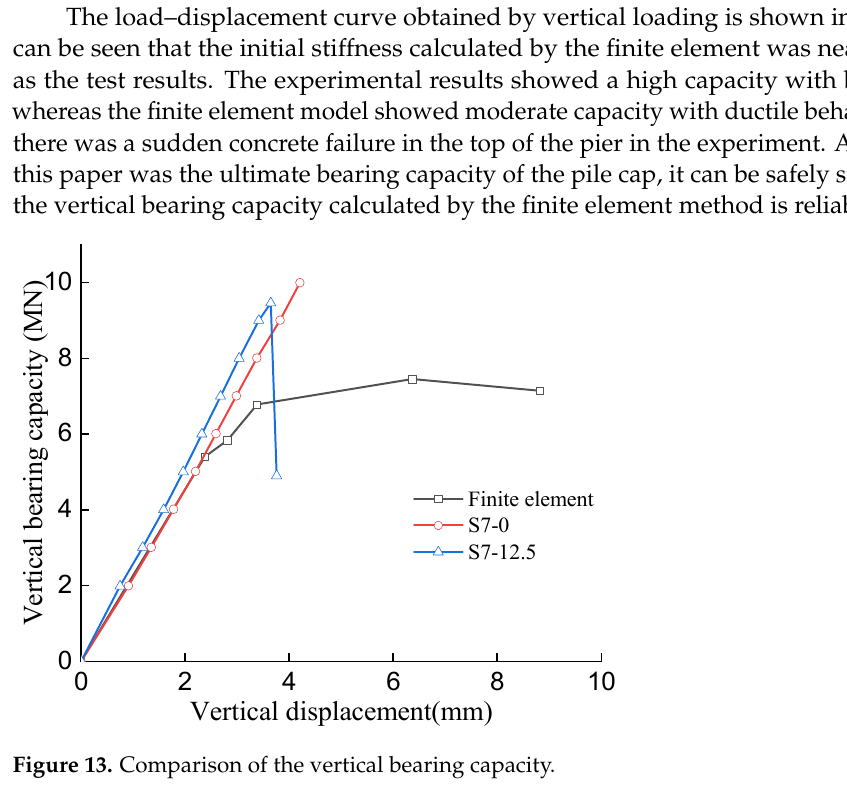
( c ) Figure 14. Diagrams of different structural models. ( a ) Shear key only; ( b ) bottom plate; ( c ) bottom plate + shear key.